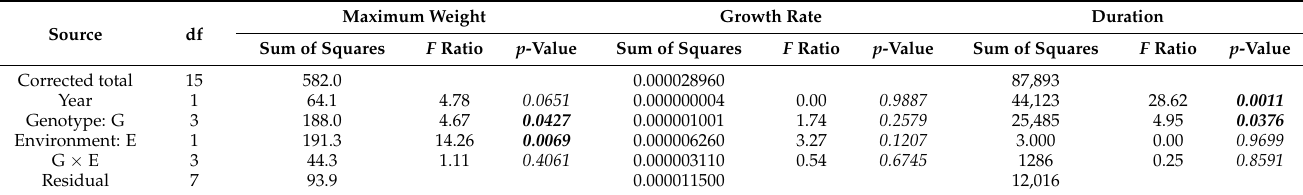
Table 1. Analyses of Variance for the Estimates of the Grain Weight (mg) Deposition Parameters: Maximum Weight, Growth Rate and